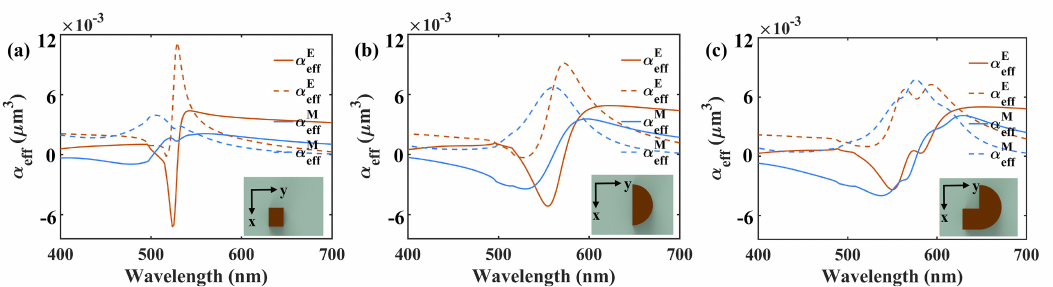
Figure 2. The effective polarizabilities of the square only nanostructure ( a ), the semicircle only nanostructure ( b ) and the hook shaped nanostructure ( c ) with periods P x = 220 nm, P y = 340 nm.